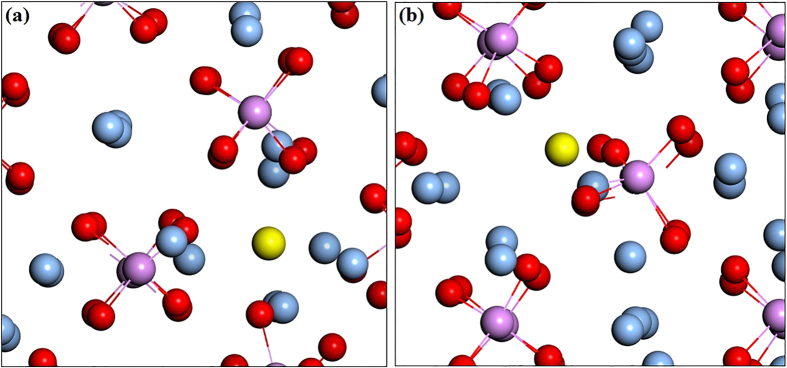
Atomic geometry of the relaxed structures of the (a) Lii and (b) Lii(s) configurations in Ag3PO4.